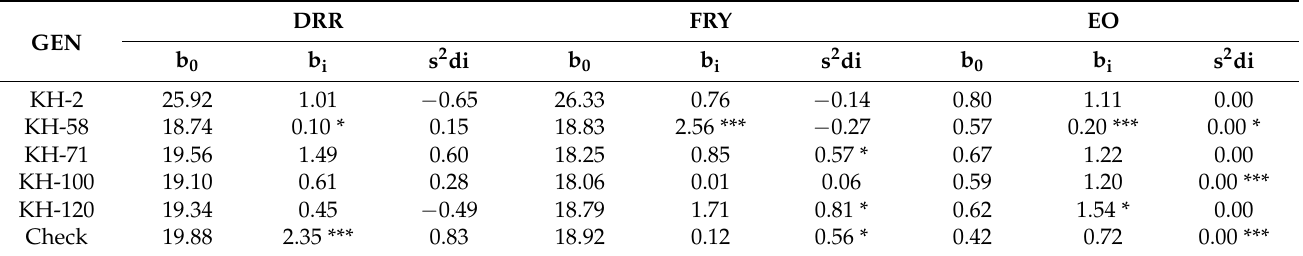
Table 3. Mean and stability parameters for the yield traits of six high-yielding genotypes of C. caesia .